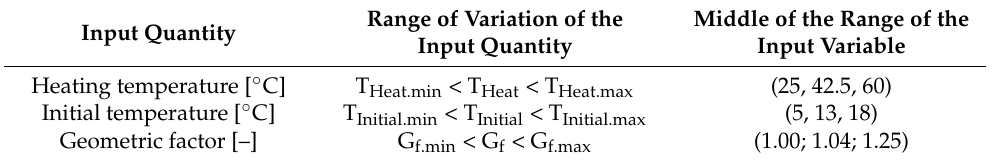
Table 2. Ranges of variation of the input quantities of the experiment plan. Input